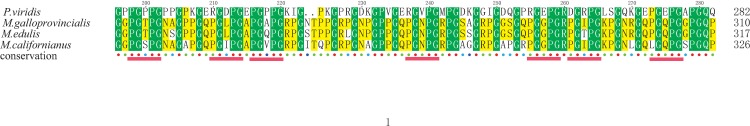
Comparison of partial preCol-P sequences between P. viridis and Mytilus species.Red underlined sequences are XGXPG repeats.